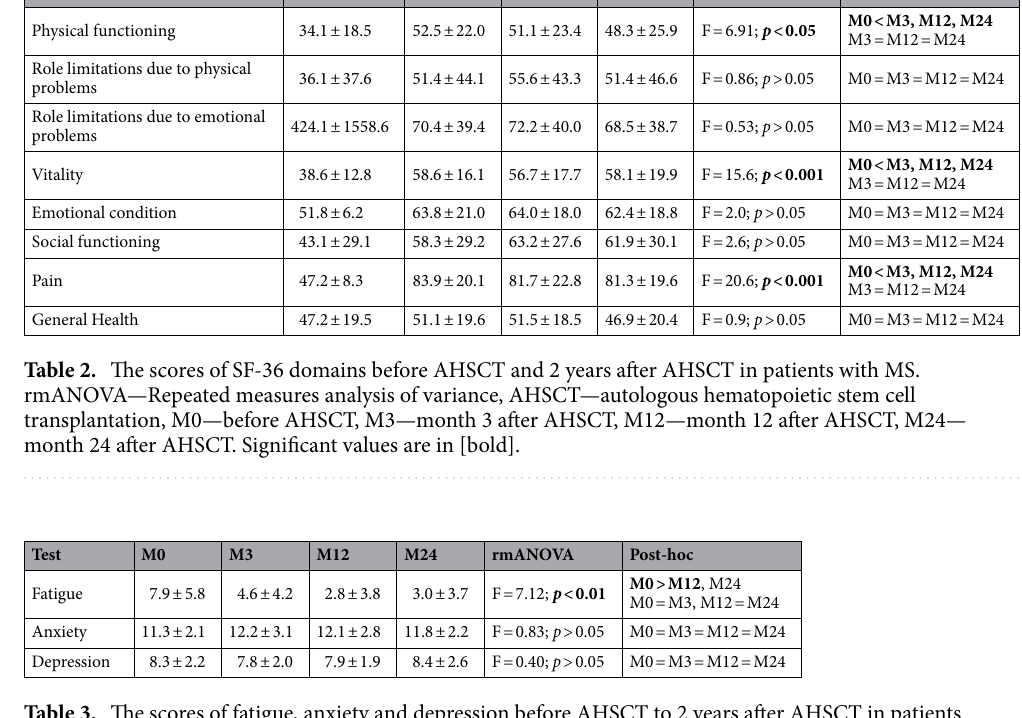
Table 3. The scores of fatigue, anxiety and depression before AHSCT to 2 years after AHSCT in patients with MS. rmANOVA—Repeated measures analysis of variance, AHSCT—autologous hematopoietic stem cell transplantation, M0—before AHSCT, M3—month 3 after AHSCT, M12—month 12 after AHSCT, M24— month 24 after AHSCT. Significant values are in